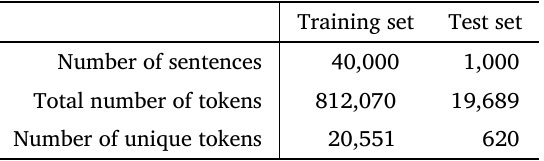
Table 16: Machine translation corpus